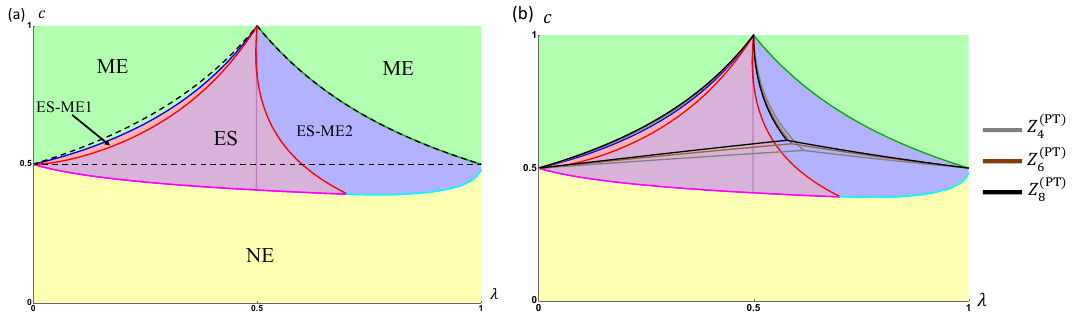
√ = 0 . 5 . The (cid:15) in A 1 B , and E V for n = 4 , 6 , 8 . n